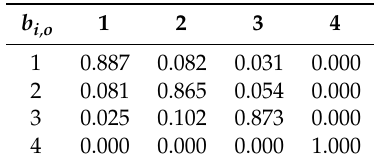
Table 2. Confusion or observation